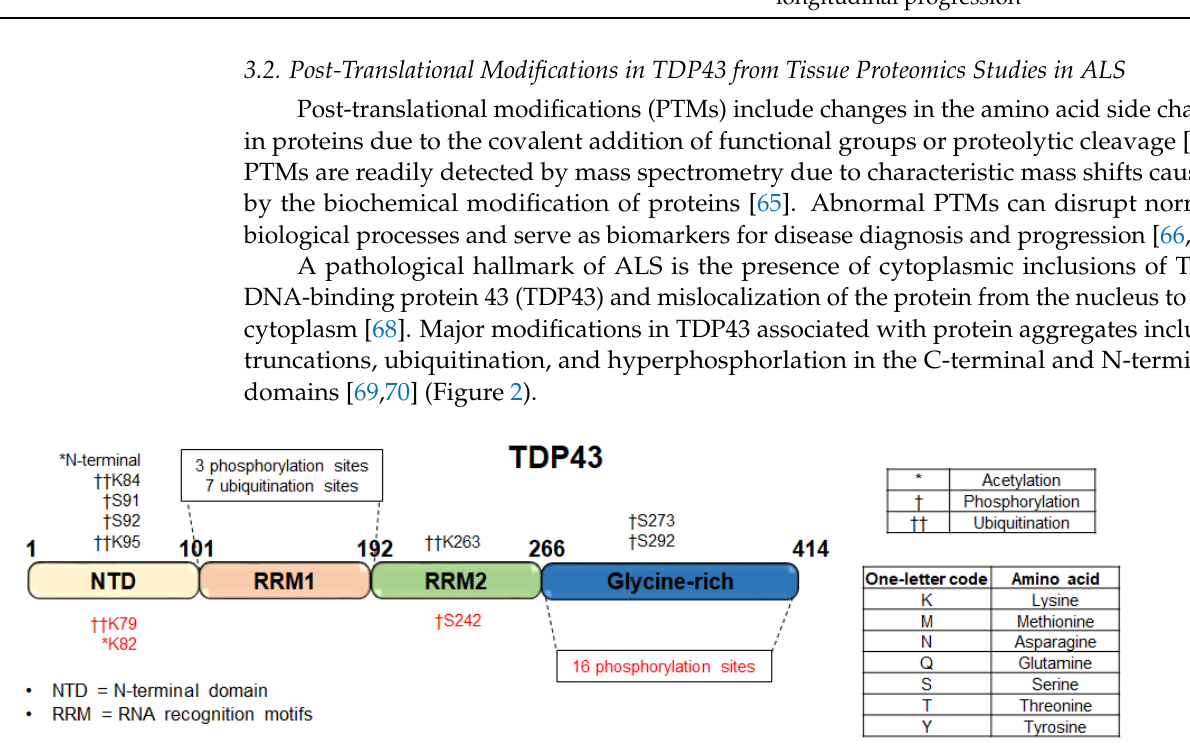
Figure 2. Schematic representation of post-translational modifications (PTMs) in TDP43 in ALS. The red font indicates putative disease-specific modifications [70] and the black font indicates all known modifications from proteomics databases (ProteomicsDB and PhosPhosite) and literature.